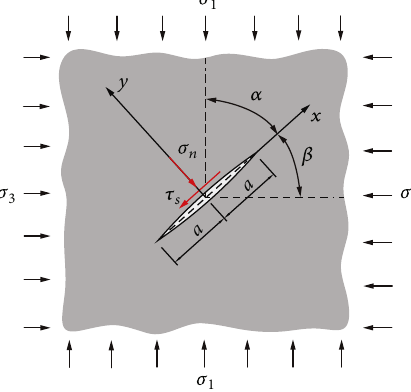
Figure 5: Semiclosed crack subjected to compression.